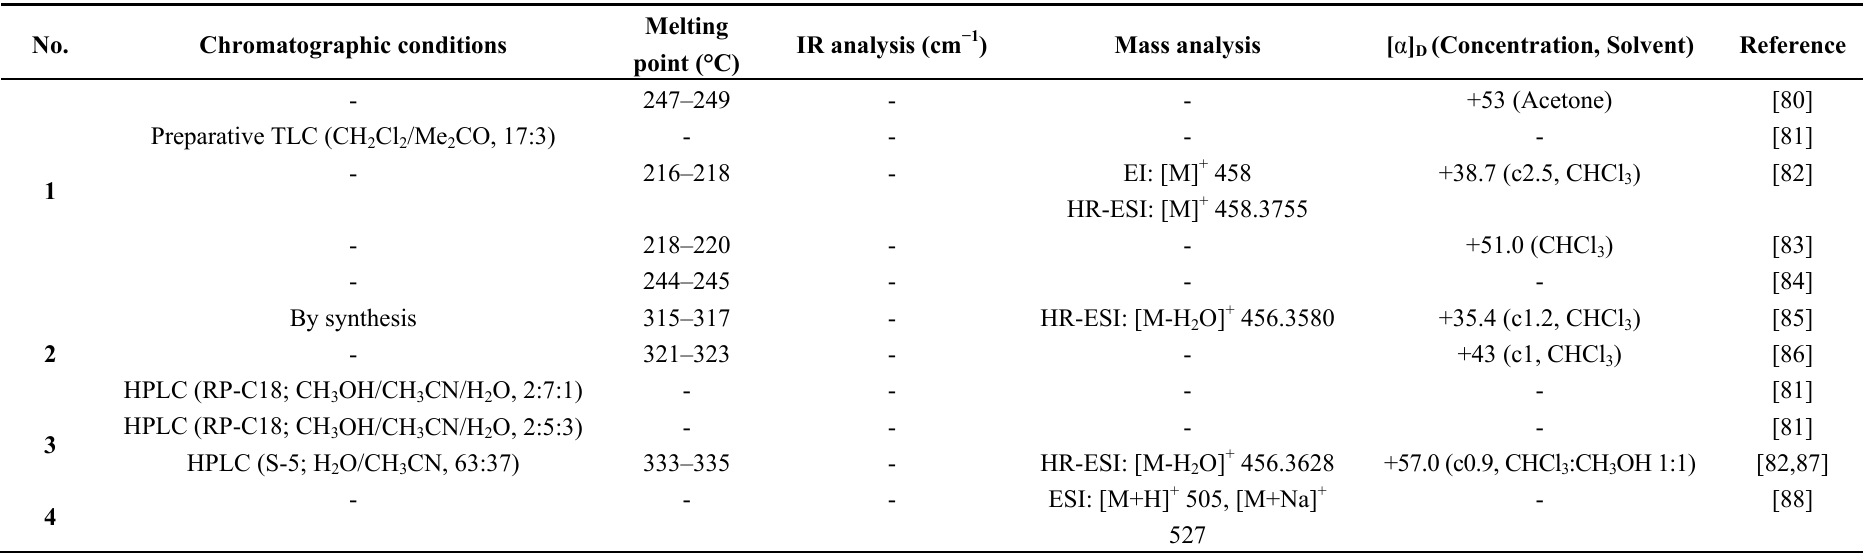
Table 4. Purification and biophysical properties of oleanes gem-dimethylated isolated from Gymnema sylvestre